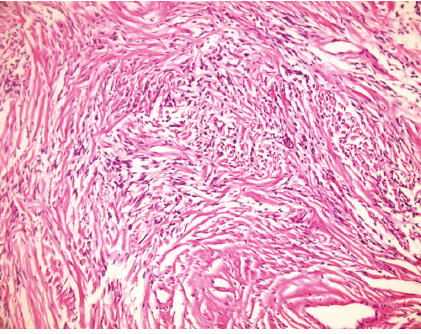
Figure 4: Patternless architecture and extensive stromal hyaliniza- tion (H&E × 200).